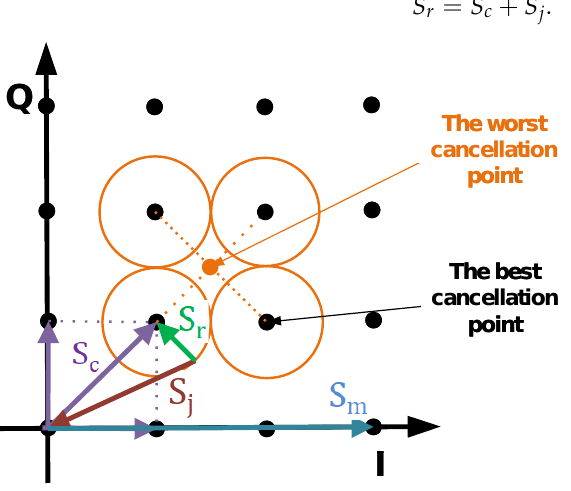
Figure 9. Distribution of the cancellation points when M =